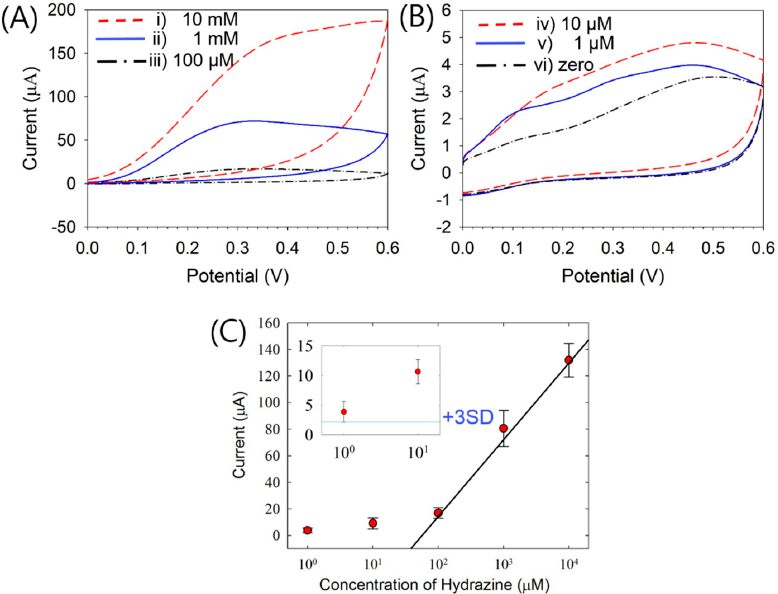
Figure 7. ( A , B ) Cyclic voltammograms for various concentrations of HZ in Tris buffer (pH 9) using pDA-ITO electrodes at a scan rate of 50 mV/s: ( A ) (i) 10 mM, (ii) 1 mM, (iii) 100 µM, ( B ) (iv) 10 µM, (v) 1 µM, and vi) zero. ( C ) Calibration plot of anodic currents at 0.3 V. The 3SD line represents the mean current plus three times the standard deviation at 0.3 V for 0 µM HZ. The error bars indicate the standard deviations of six measurements.